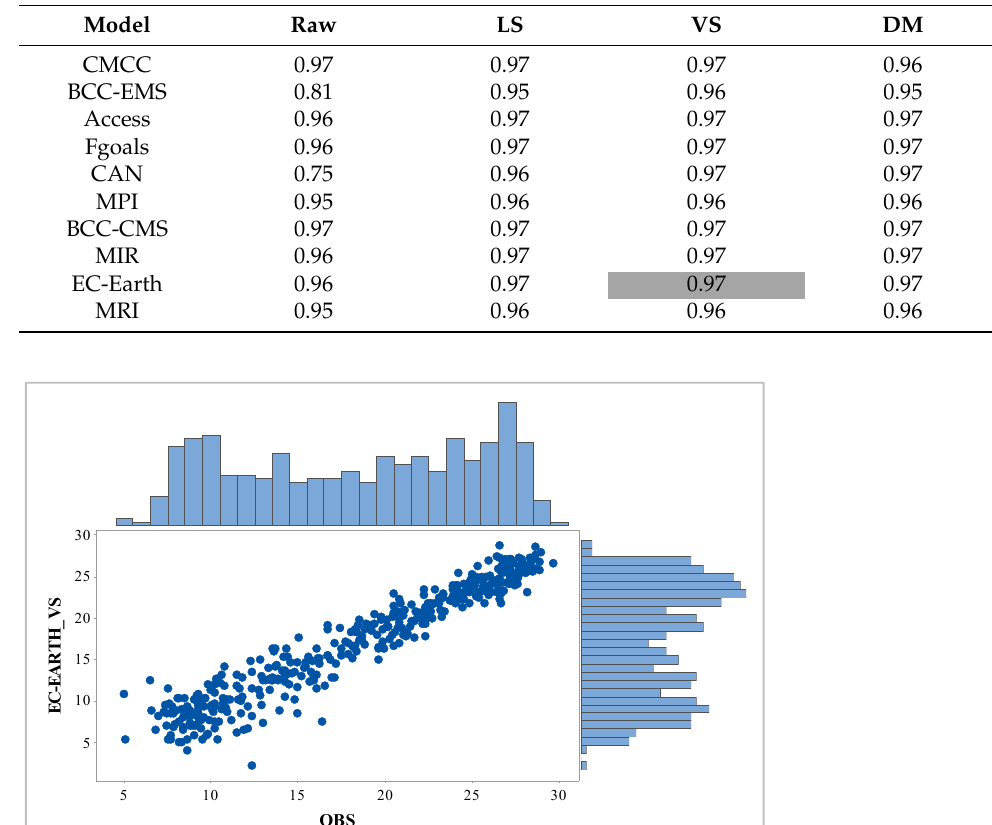
Table 4. Correlations between temperature reference data and GCMs data with different bias correction methods.